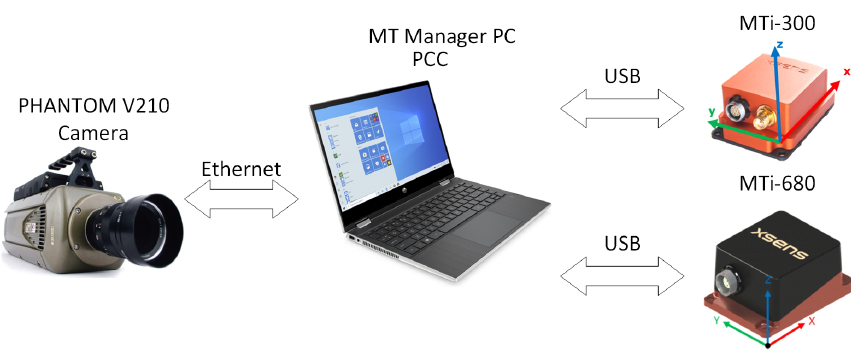
Figure 5. Connection diagram of the computer with sensors (MTi XSENS) and camera (PHAN- TOM